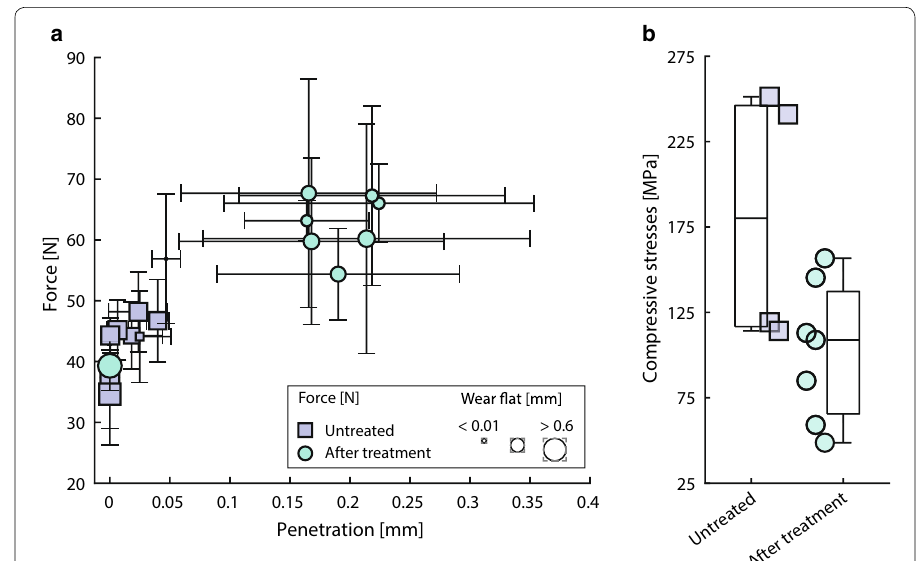
Fig. 7 Cutting forces in granite. The cutting forces exerted on the tool during the scratch experiment are shown in a as a scatter plot for Grimsel granite under untreated (violet squares) and after-treatment (green circles) conditions. Symbol sizes indicate the wear flat values measured at the tool tip (see legend). In b , the compressive stresses exerted on the rock during the test are calculated, using the measured forces and the projected surface area, calculated from the tool penetration depth and the wear flat values. In this plot, the scattered data distributions, representing the strength values, are summarized by boxes, where the central mark indicates the median value, the bottom and top edges of the box indicate the 25th and 75th percentiles, respectively, and the error bars represent the standard deviation